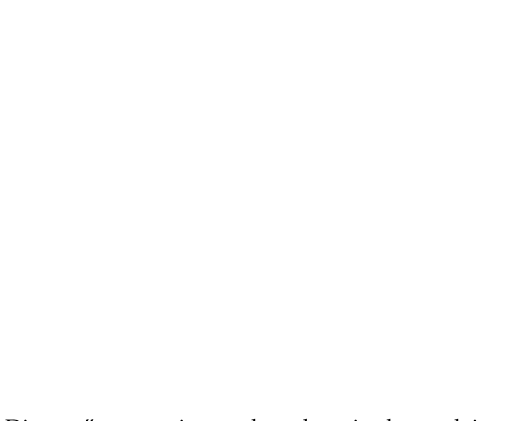
Figure 11. An employee peer issues the “CloseDispute” transaction to close the raised complaint. Last, we show the employee and employer contract histories by looking up their IDs and viewing their previous contract statistics in Figures 12 and 13, respectively. We show the total number of contracts, specifying their status as terminated, active, or pending. We show similar stats for the number of disputes and their status as open or closed. Retrieved stats can be easily extended to compute the desired metrics since all contracts and transactions are stored transparently in the blockchain network.